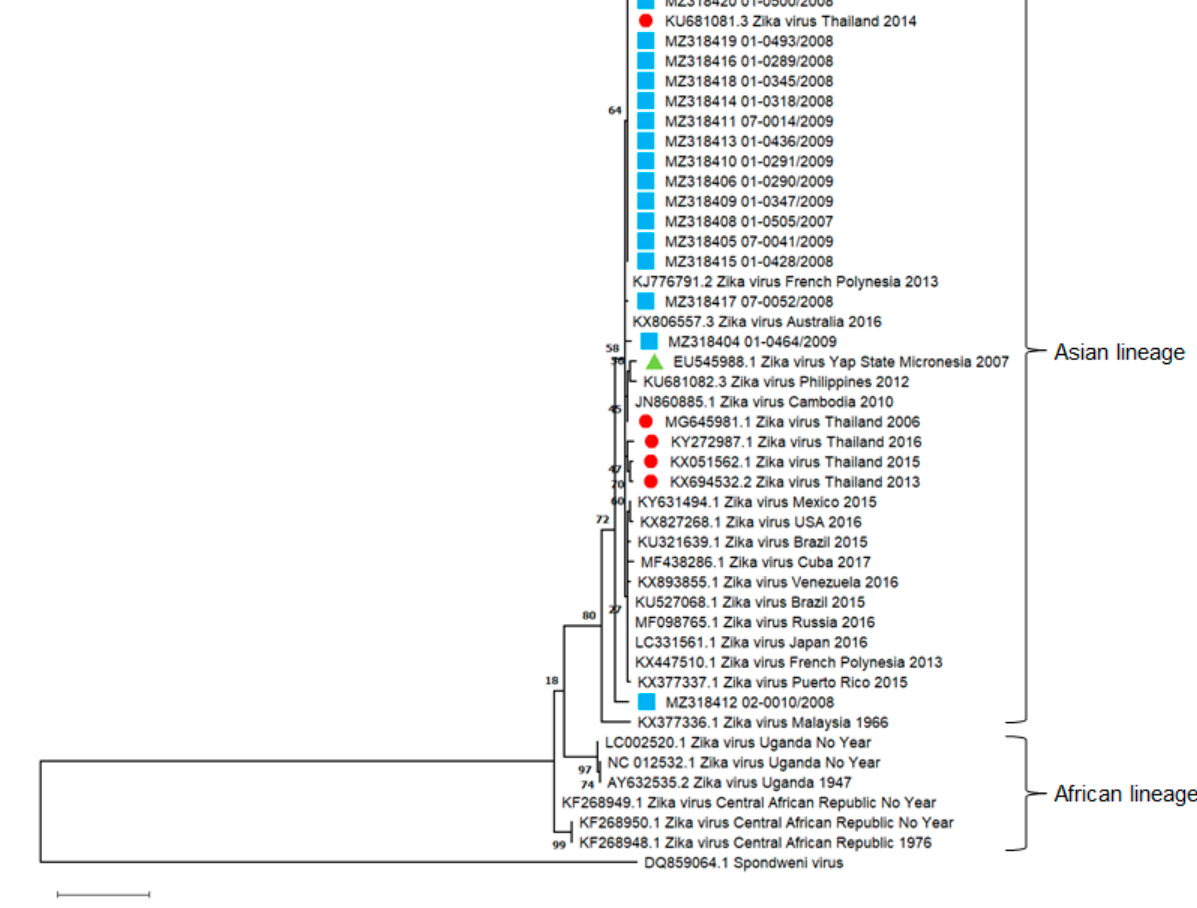
Figure 5. Phylogenetic analysis of ZIKV fragments (300 bp). The tree was constructed by using ZIKV sequences obtained from school-aged children in Ratchaburi province, Thailand, from 2007 to 2009 (blue square), ZIKV sequences from other studies in Thailand (red circle), ZIKV sequences (EU545988.1) from Yap Islands in Micronesia 2007 (green triangle). The maximum likelihood method with a bootstrap value of 1000 was applied. Sample names and nucleotide sequence accession numbers are marked with symbols. The Spondweni virus (DQ859064.1) sequence served as the out-group.